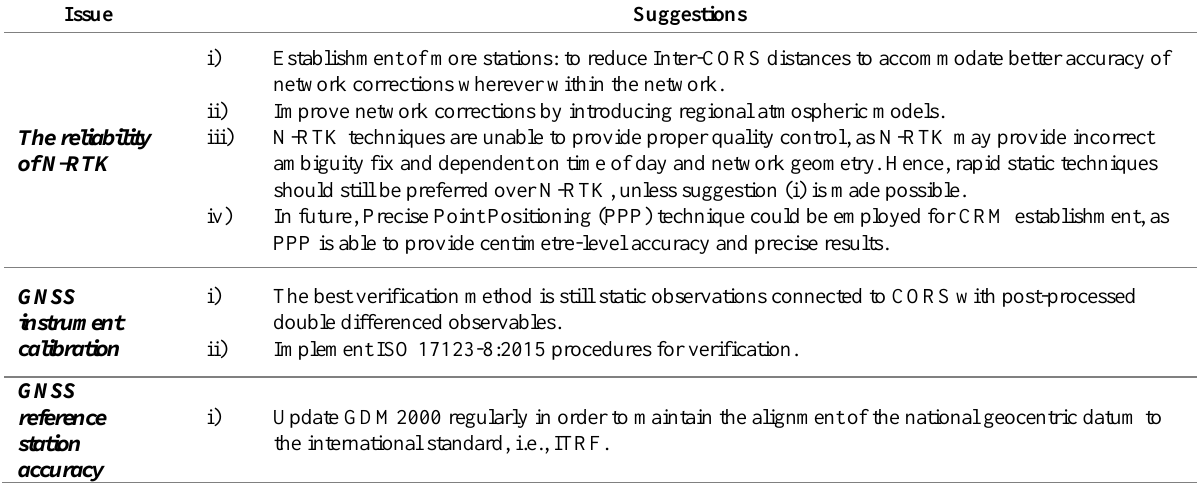
Table 1. Suggestions to improve the best practice